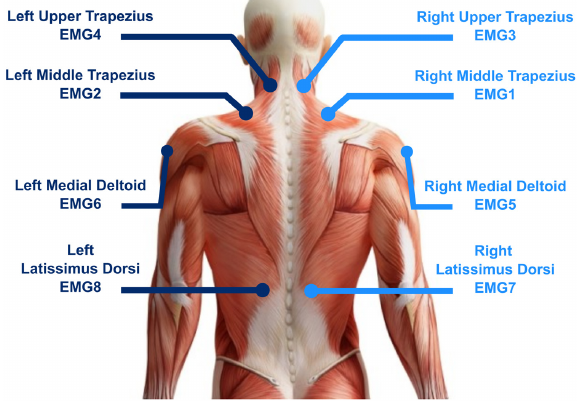
Figure 1. Positioning of the EMG sensors on specific muscles. Sensors 2023 , 23 , x FOR PEER REVIEW